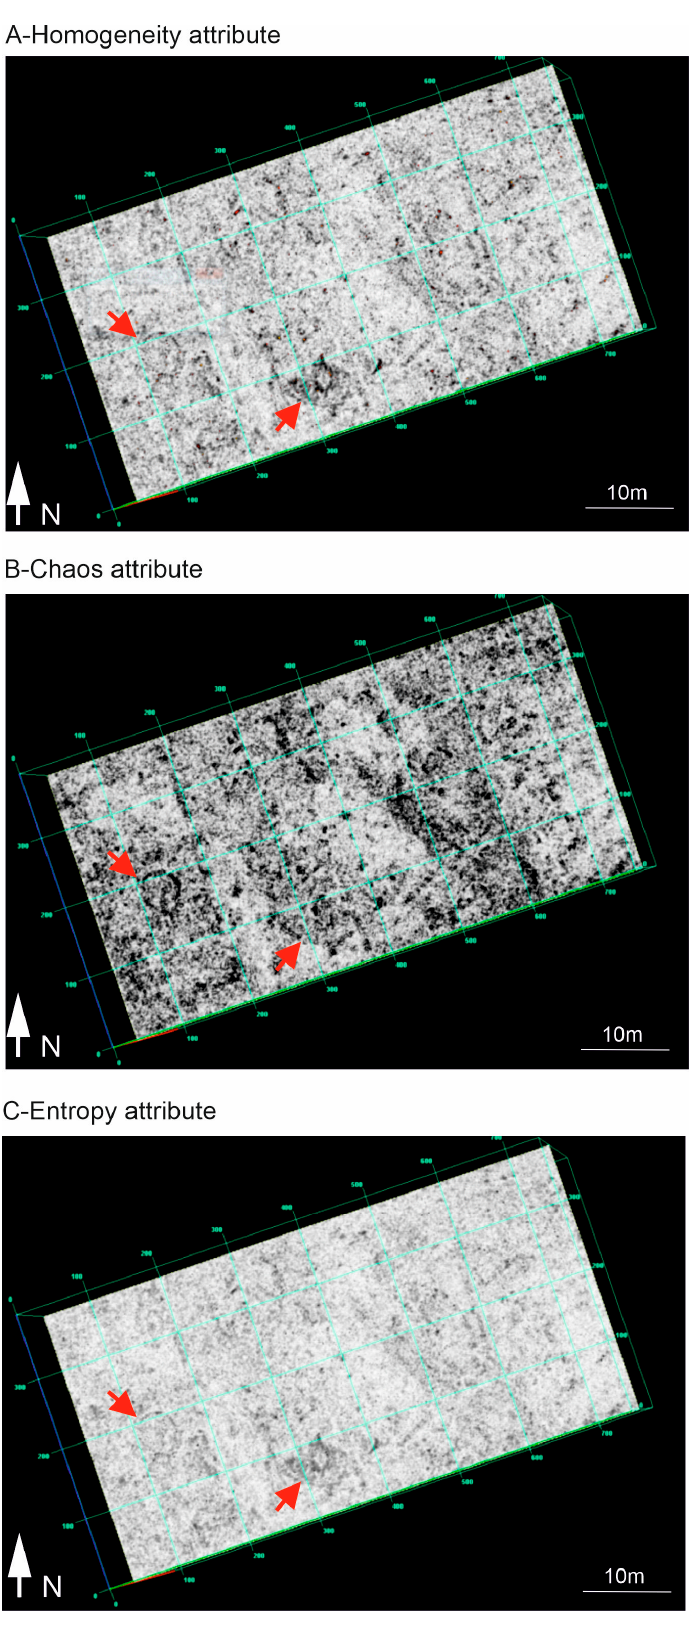
Figure 6. Example of texture attributes calculated on the same depth-slice. See text for details.